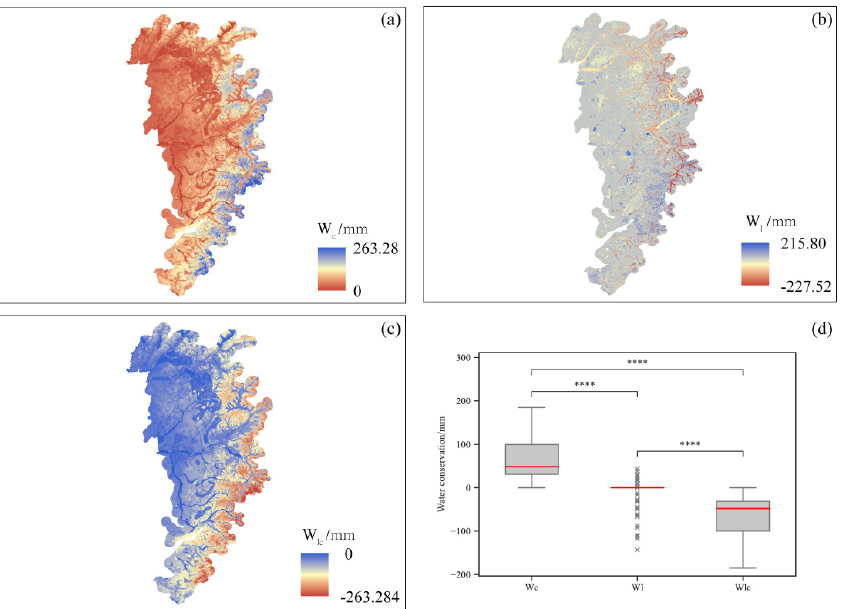
Figure 6. Spatial distributions and effect sizes of climate change, LULC and their interactive effects. ( a , b , c ) represented the spatial change in water conservation due to the separate effect of LULC change, climate change, and the combined effects of LULC change and climate change. ( d ) represented the analysis of variance (ANOVA) for water conservation in three scenarios. “****” represents the node.